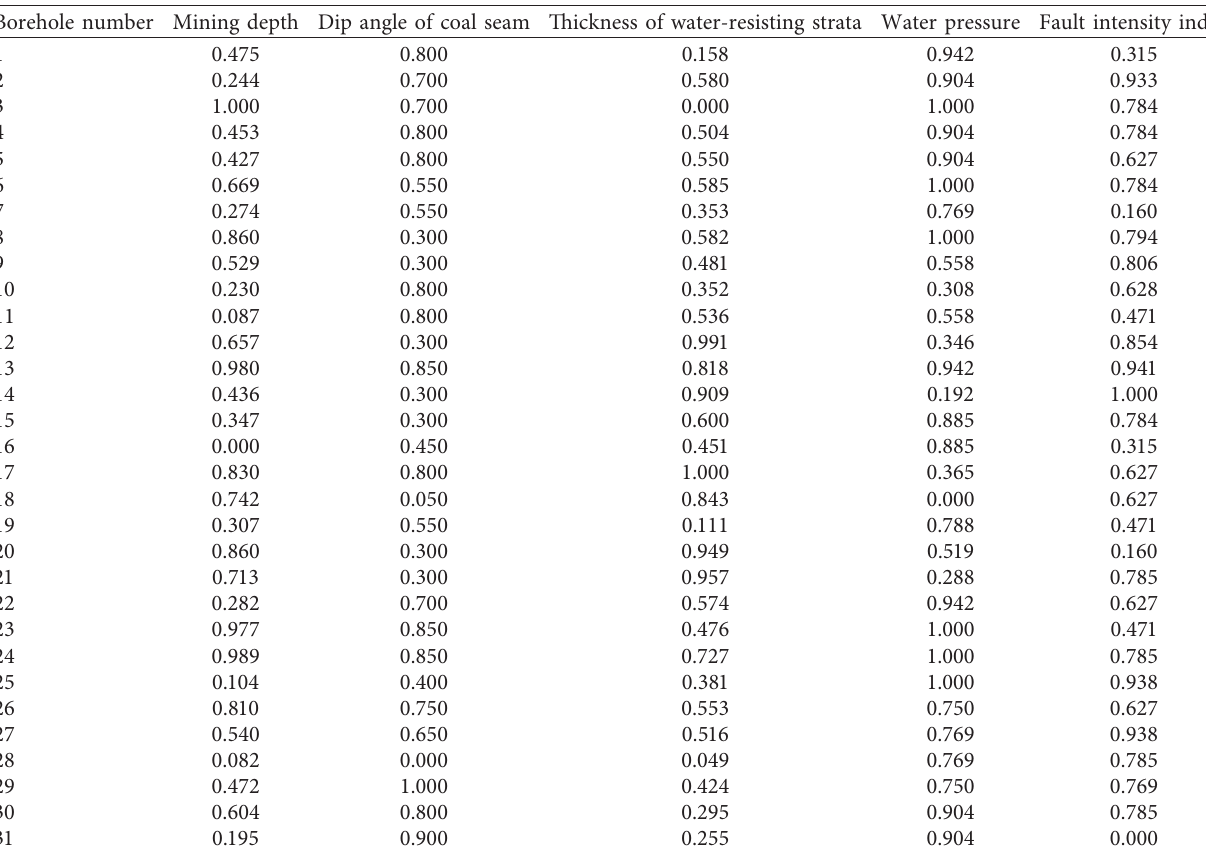
Figure 2: The zoning maps of seven major controlling factor. (a) Mining depth. (b) Dip angle of coal seam. (c) Thickness of water-resisting strata. (d) Water pressure. (e) Fault intensity index. Table 2: The normalization of original data of